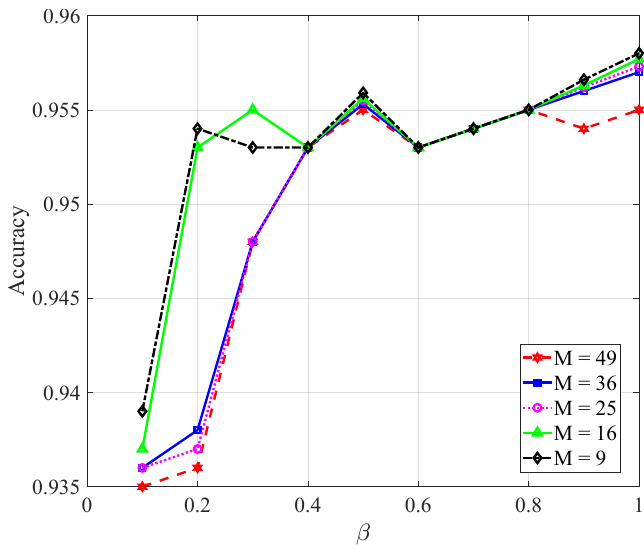
Figure 2. Comparison of the accuracy of different schemes versus β .